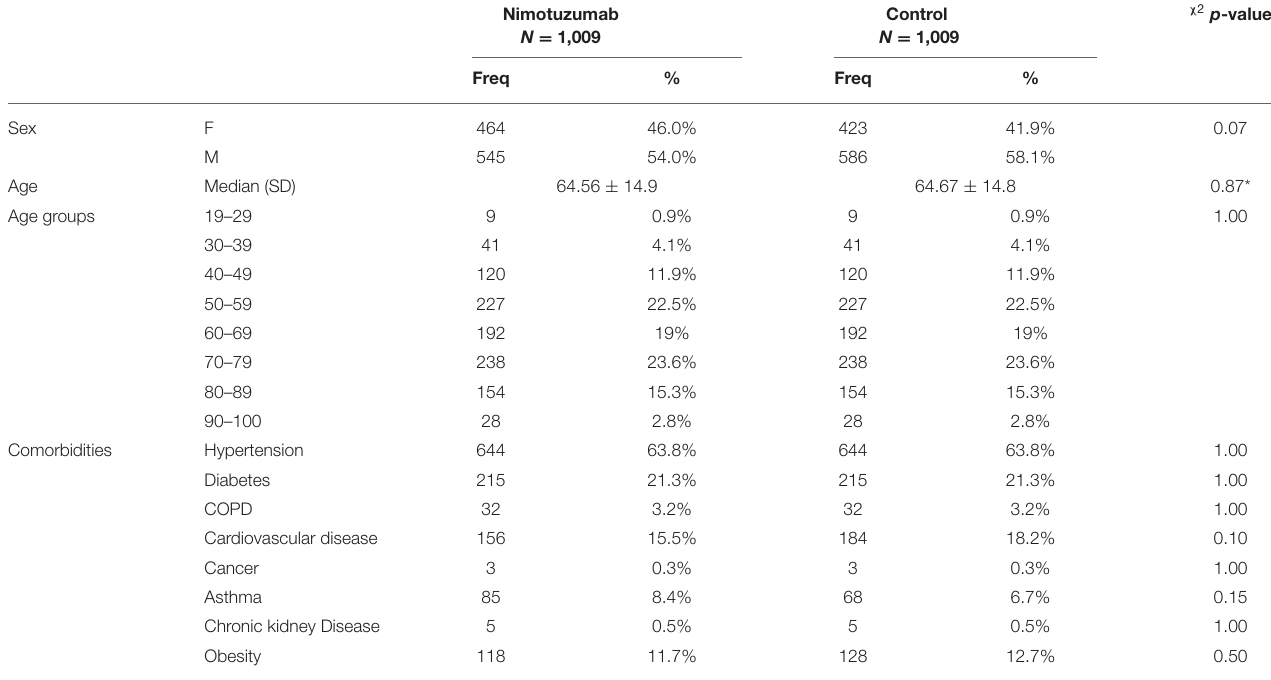
TABLE 2 | Baseline characteristics of patients treated with nimotuzumab vs. controls not receiving immunomodulatory